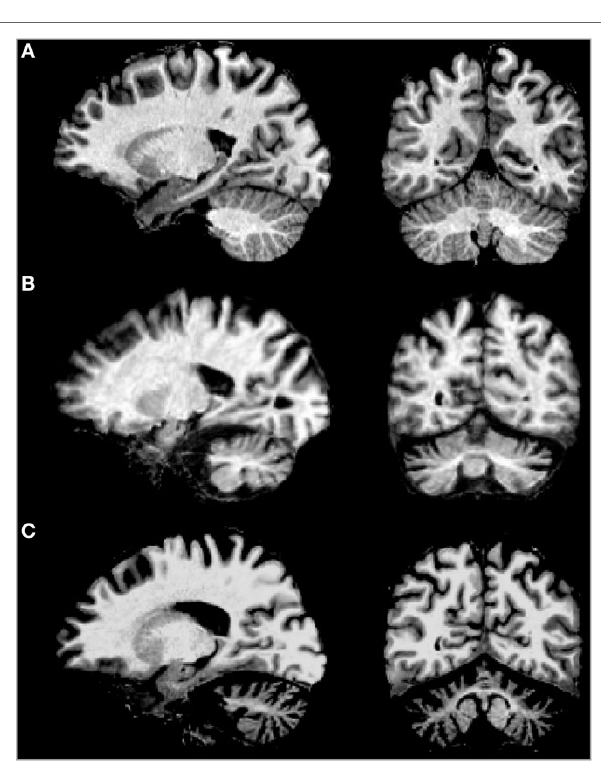
FiGURe 3 | MRI of sagital (left) and coronal (right) examples of (A) normal brain, (B) spinocerebellar ataxia type 2 (SCA2) patient with early clinical manifestation, and (C) SCA2 patient with full ataxia manifestation. Note the severe cerebellar volume loss in gray and white matter in advanced stages of the disease.